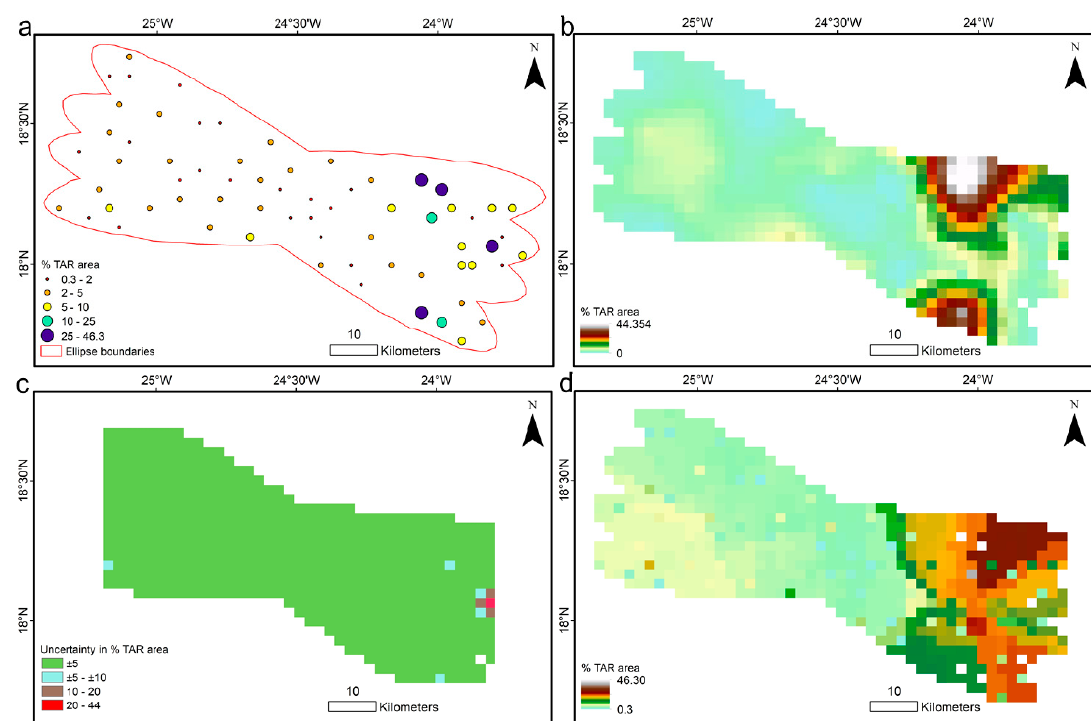
Figure 5. TAR distribution across the study area. ( a ) % TAR area within the mapped grids. ( b ) TAR distribution as areal % per grid spatially interpolated using 53 mapped grids. ( c ) % uncertainty in interpolated % TAR area estimated using 13 mapped grids. ( d ) Areal distribution of TARs based on spatial interpolation using all the 66 mapped grids.